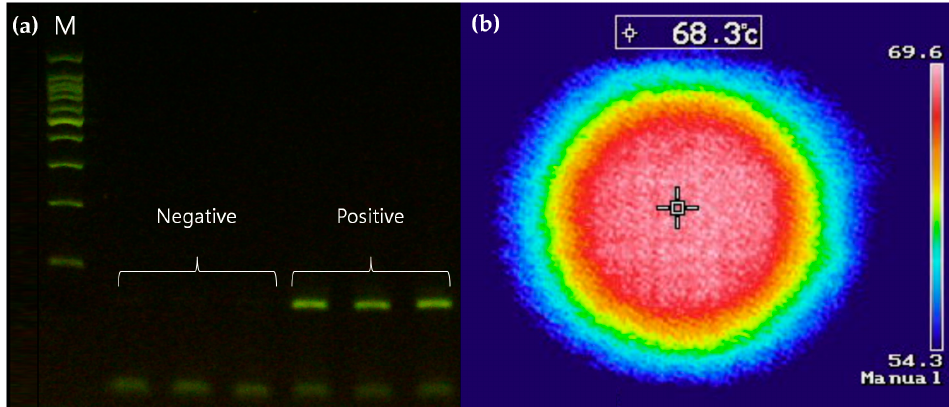
Figure 4. ( a ) The electrophoresis results of the PCR amplification using a thermocycler after the lysis reaches 65 °C for 3 min in a microcentrifuge tube. A negative result represents a lysis without Salmonella , whereas a positive result contains Salmonella . ( b ) The temperature of the cell lysis chamber measured by an infrared camera (Keysight, Santa Rosa, CA, USA) during the heating process with a laser module, which tells when the temperature in the cell lysis chamber reaches above 65 °C.